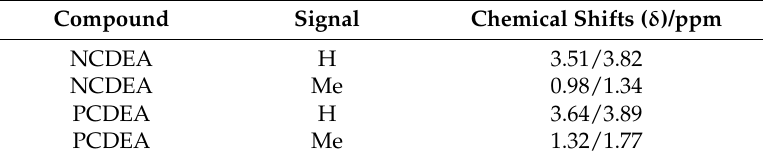
Table 1. Experimental 1 H NMR for N , N -diethylamide derivatives (aliphatic part only).